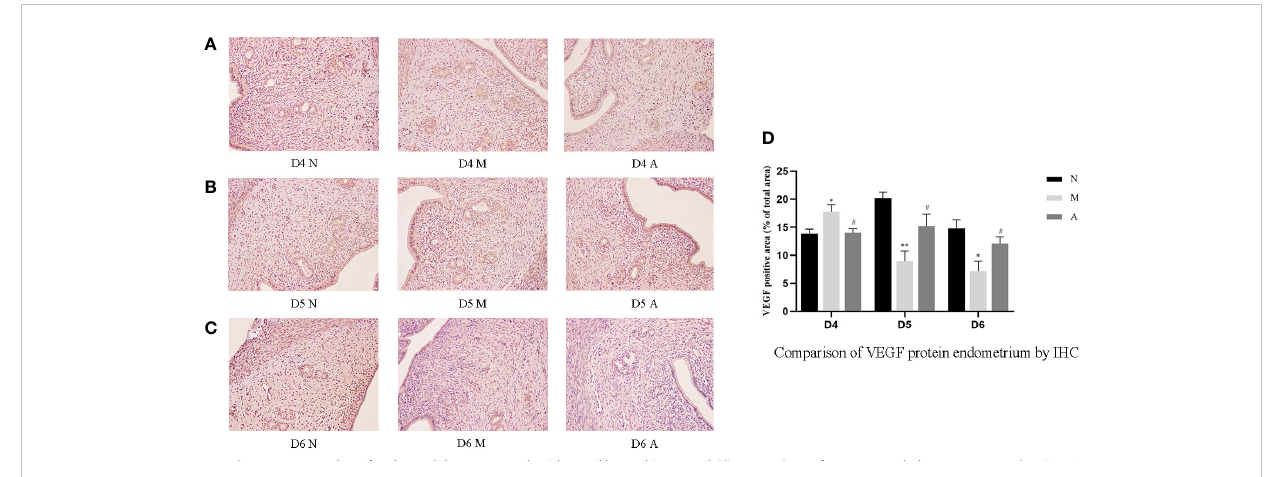
FIGURE 5 The expression of endometrial VEGF protein: (A) D4; (B) D5; (C) D6; and (D) comparison of VEGF protein by mean gray value (n=3). *or** represents that there is signi fi cant difference between M and N groups ( P < 0.05 or P < 0.01), #or ## represents that there is signi fi cant difference between A and M groups ( P < 0.05 or P < 0.01). Original magni fi cation *200. VEGF, Vascular endothelial growth factor; IHC, Immunohistochemistry; D, The embryo day; D4 N, D4 normal group; D4 M, D4 model group; D4 A, D4 acupuncture group; D5 N, D5 normal group; D5 M, D5 model group;